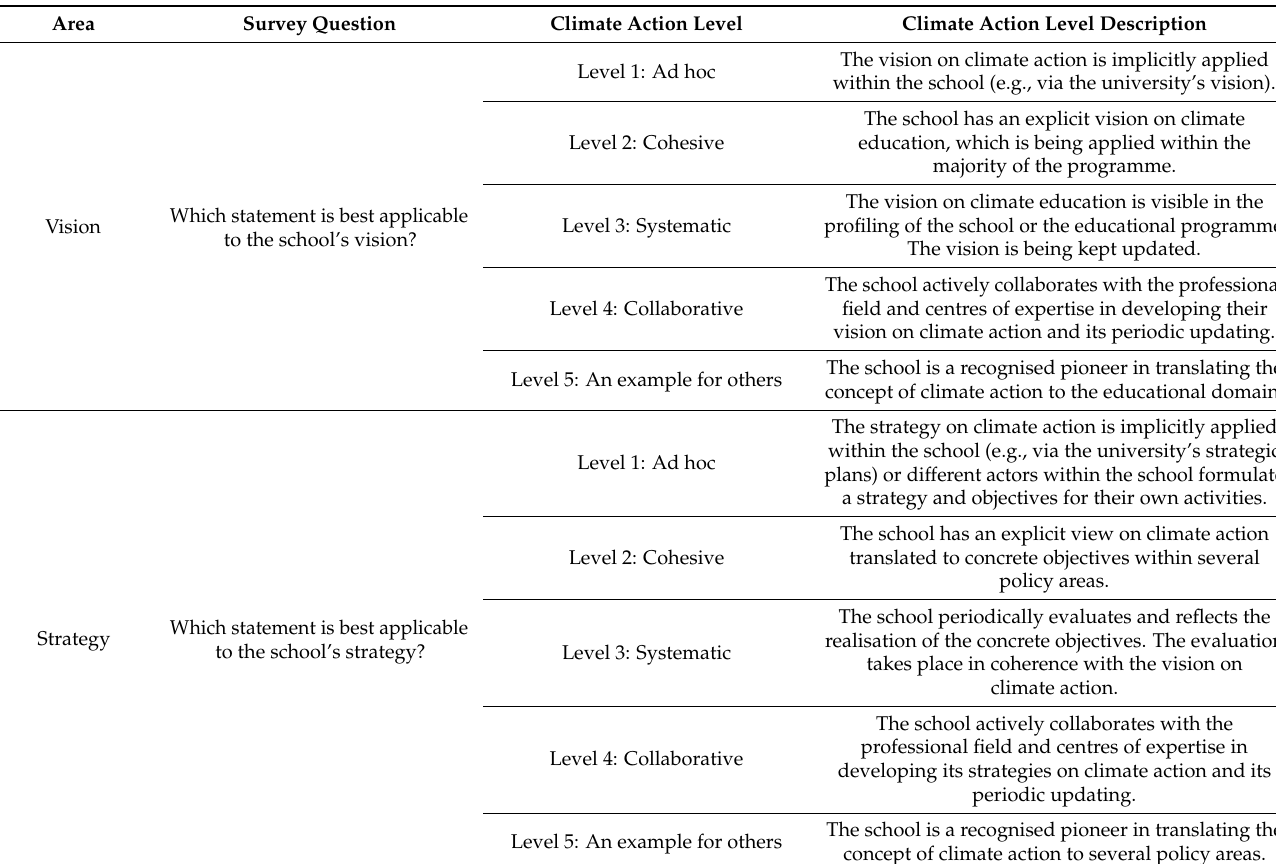
Table A1. The adaptation of the AISHE model (2016) for climate action by